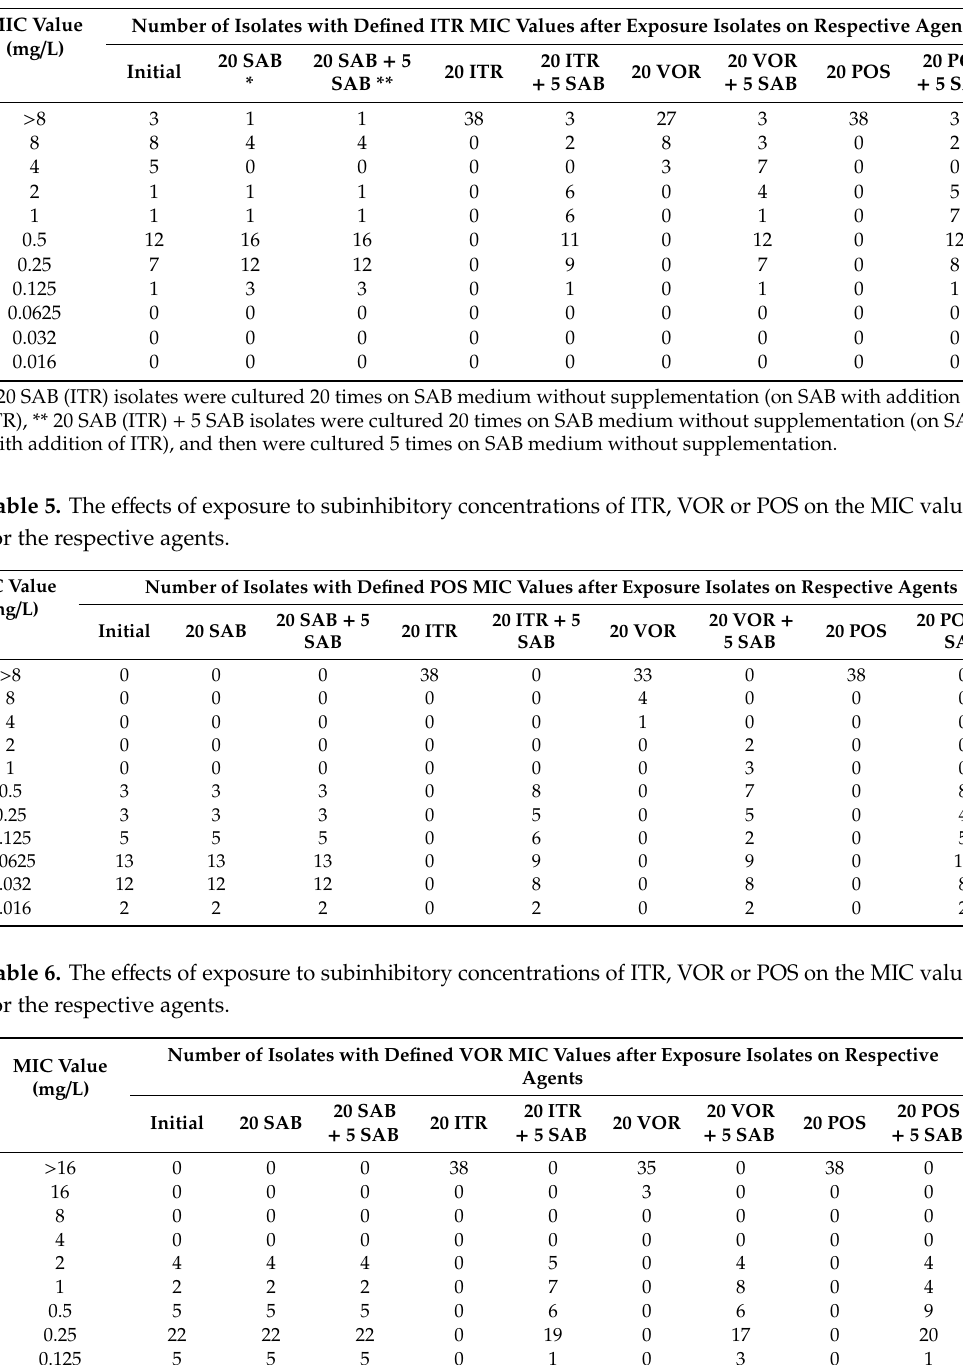
Table 4. The e ff ects of exposure to subinhibitory concentrations of ITR, VOR or POS on the minimal inhibitory concentration (MIC) values for each agent.